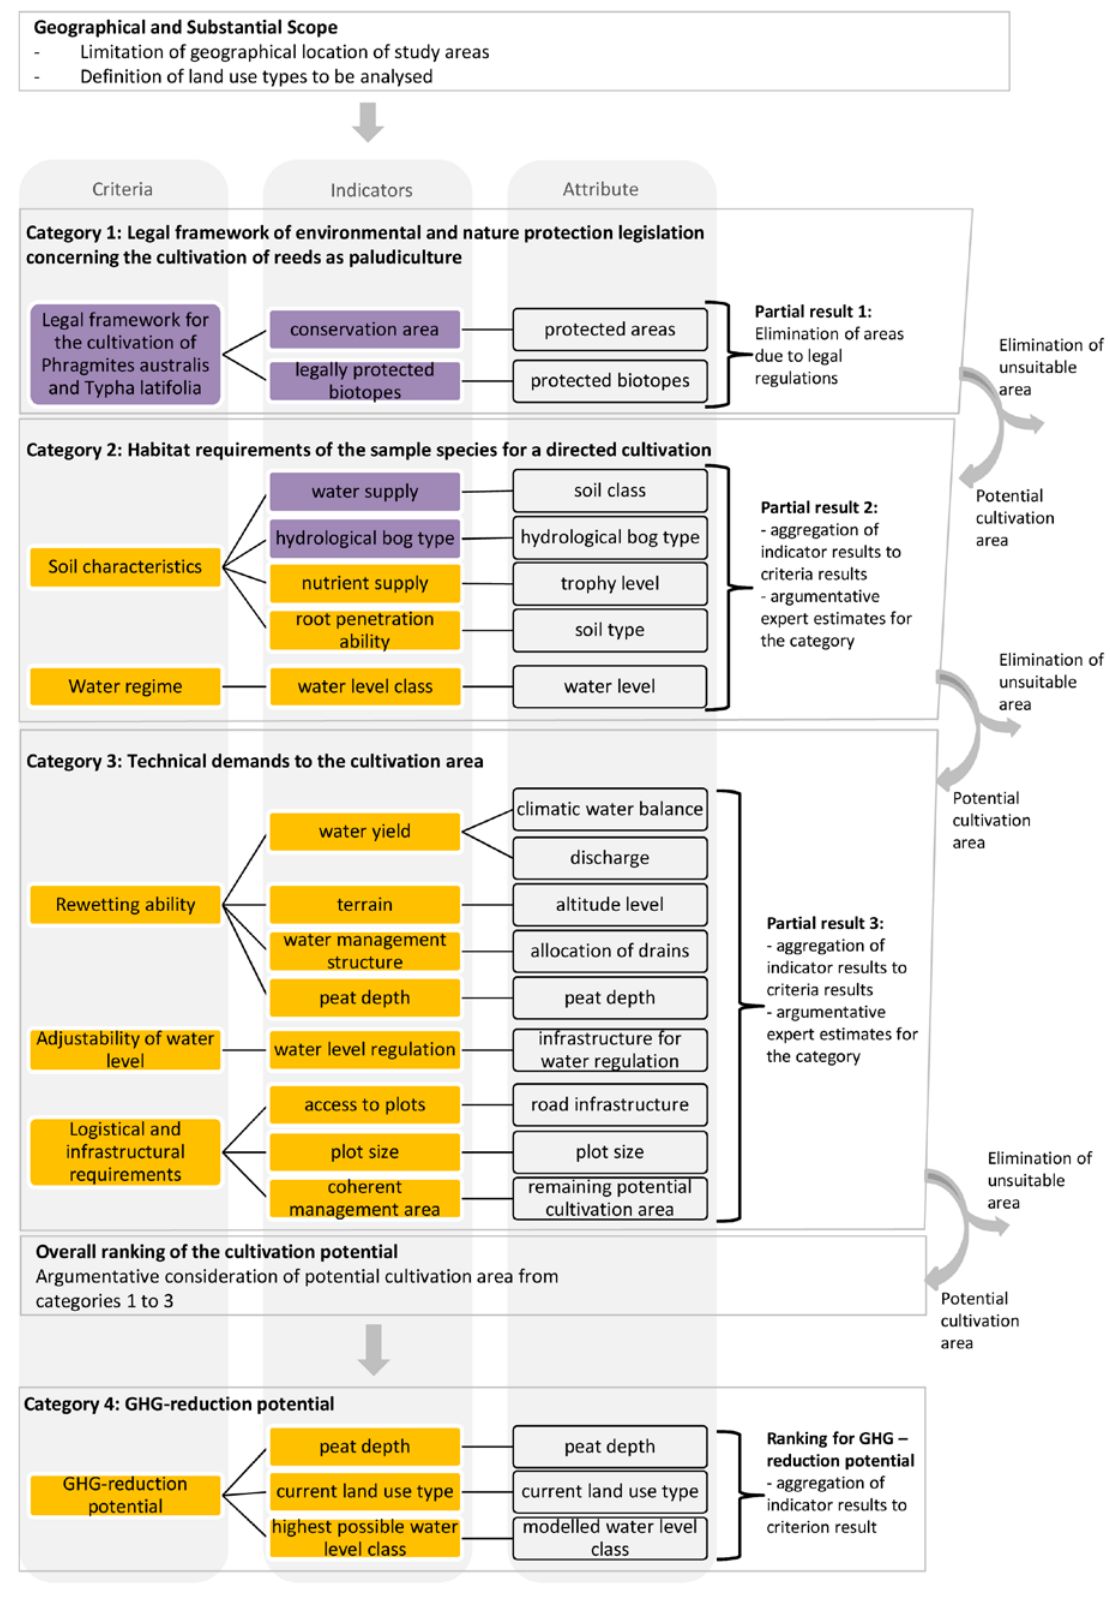
Figure 1. Structure of the tool. The analytic process follows the sequence from Category 1 to Category 3 and deals with indicators within each category in the order presented here. Indicators and criteria shaded in orange have ordinal scales; those shaded in purple have nominal scales. A significant reduction of effort required for analysis is achieved by eliminating ‘unsuitable’ area after every assessment